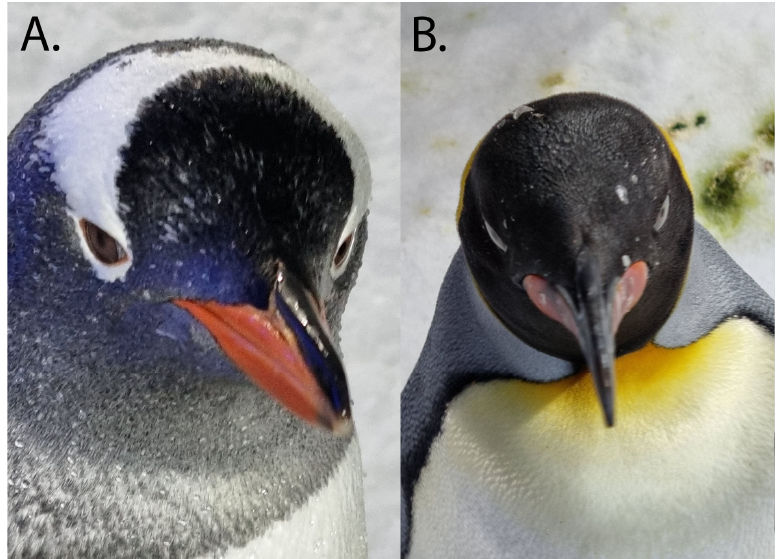
Figure 11. There is limited binocular overlap in penguins because the eye faces more laterally than rostrally, although both pupils are visible at the same time in these penguins in air. ( A ) Gentoo penguin Pygoscelis papua ; ( B ) King penguin Aptenodytes patagonicus . Credit: PWH. Stereopsis also requires integration of the image from each eye to detect horizontal disparity. Unlike in mammals, birds have a completely crossed chiasm. A second